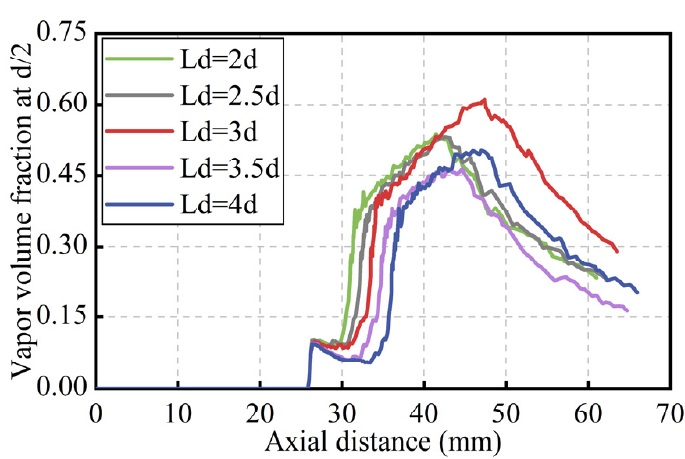
Figure 19. Effect of Ld on the cavitation. As can be seen from Figure 18, when the axial distance is less than 40 mm (inside the nozzle), the axial velocity of the jet corresponding to different Ld is essentially the